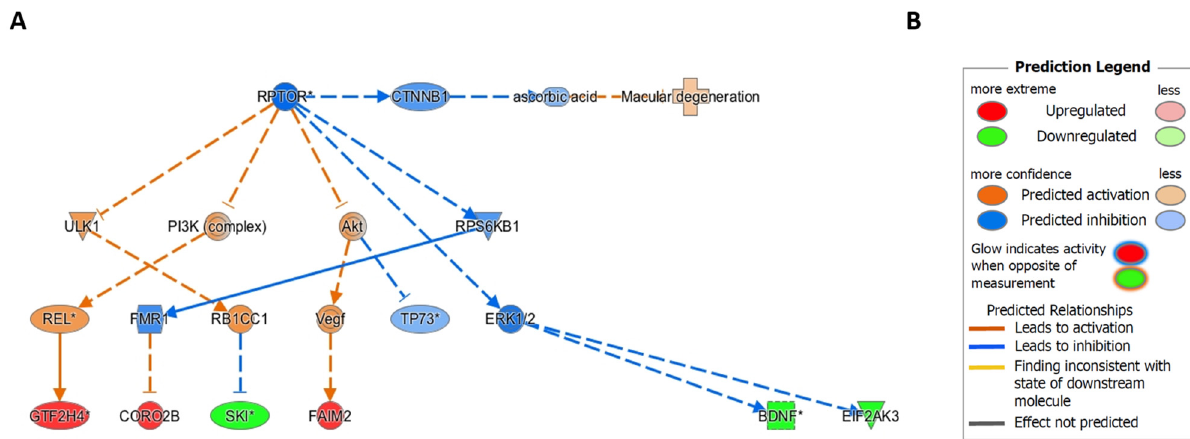
Figure 4. Ingenuity Pathway Analysis Causal Network Analysis identifies RPTOR as a master regulator for DNA methylation changes in AMD RPE. ( A ) Ingenuity Pathway Analysis Causal Network Analysis was performed on the top most differentially methylated probes identified by the 450K-array in AMD human RPE gDNA samples. RPTOR inhibition was identified as a master upstream regulator of SKI , GTF2H4 , CORO2B , FAIM2 , BDNF , and EIF2AK3. RPTOR inhibition was also found to inhibit CTNNB1 , which inhibits ascorbic acid, predicted to activate the term “macular degeneration” in IPA. ( B ) Prediction legend for the Ingenuity Pathway Analysis Causal Network Analysis.